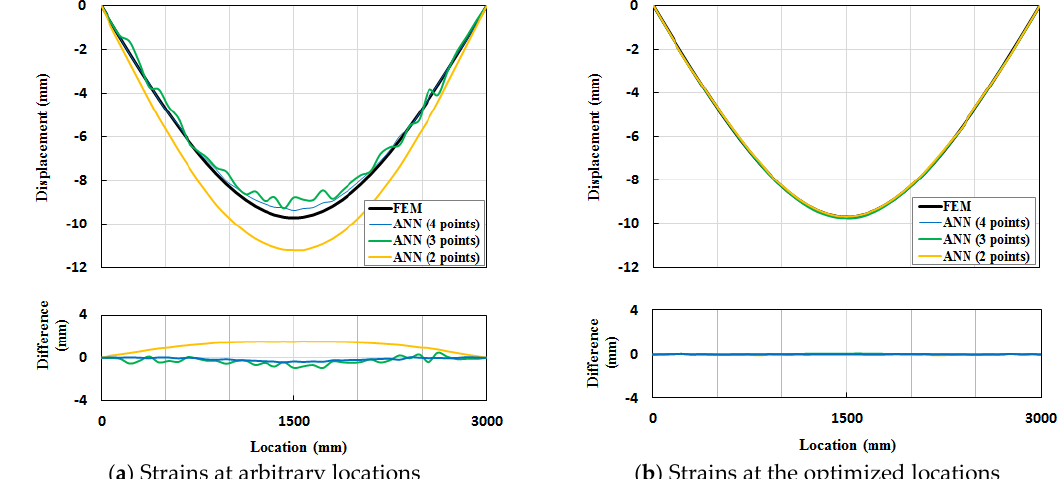
Figure 8. Overall displacements shape at t = 1 s (max. displacement).